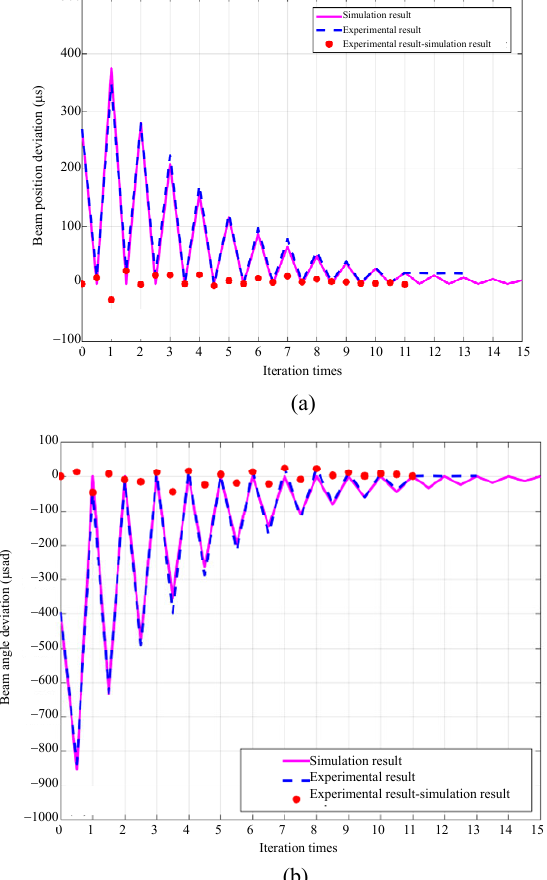
Fig. 3 Experimental and simulation results for beam alignment with the original iterative algorithm: (a) and (b) show the beam position and angle deviations,